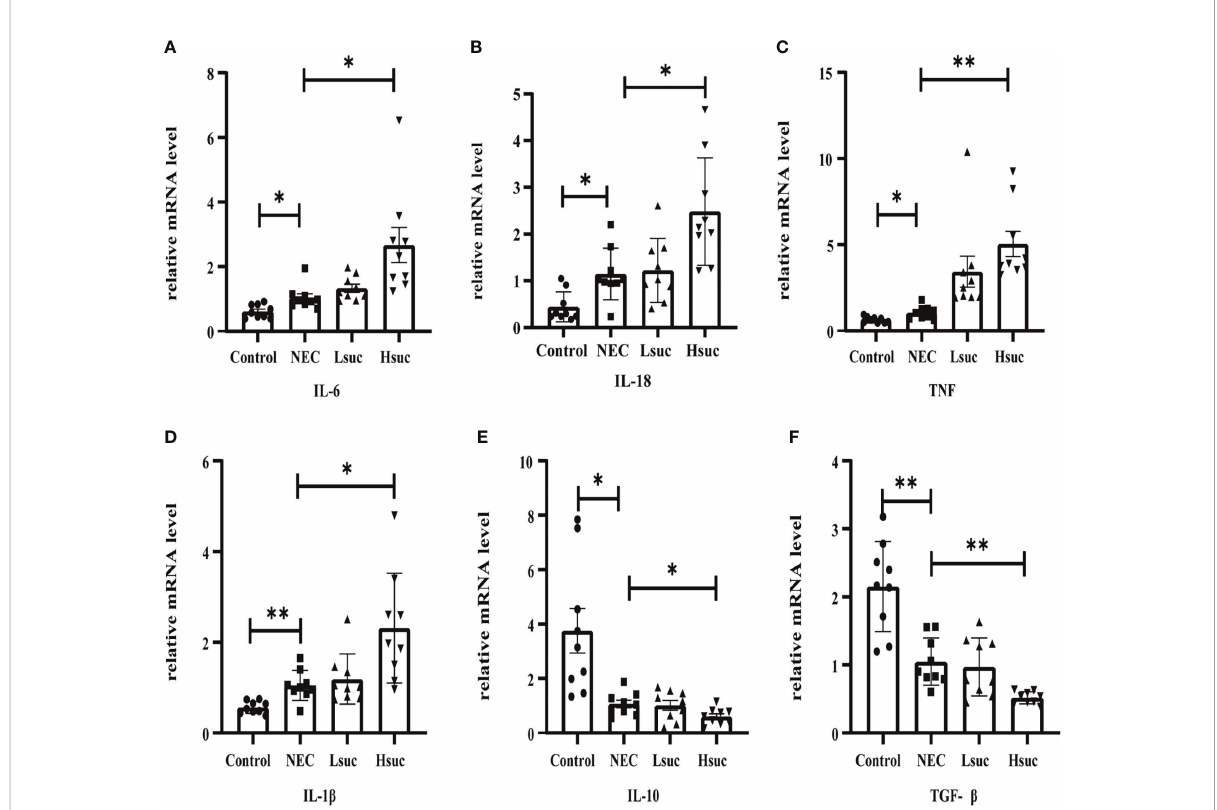
FIGURE 6 Relative mRNA expression of in fl ammatory cytokines in the intestines of mice from four independent groups (n=9 per group). (A – D) Proin fl ammatory factors; (E, F) anti-in fl ammatory cytokines. Dots indicate data from individual mice, and data are shown as the means ± SD. Statistical signi fi cance was assessed with one-way ANOVA followed by Dunnett ’ s post hoc test. * P < 0.05, ** P <